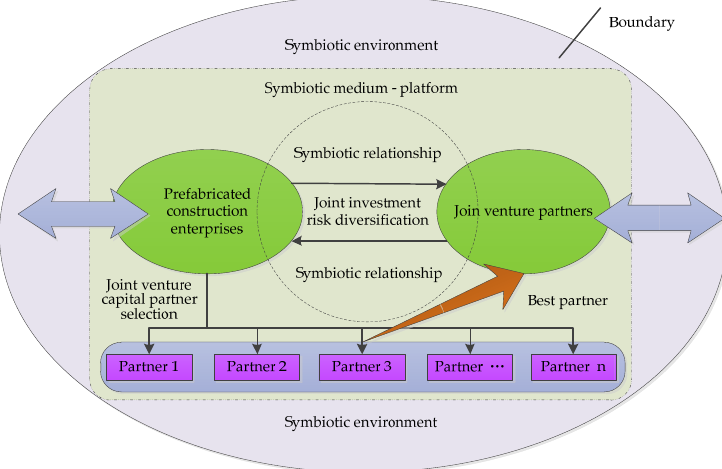
Figure 1. Theoretical model of PCEs choosing joint venture capital partners.